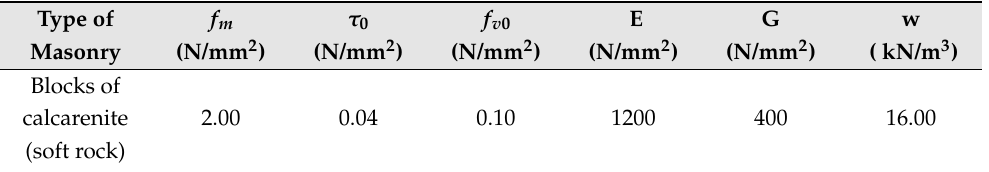
Table 1. Mechanical characteristics of masonry.